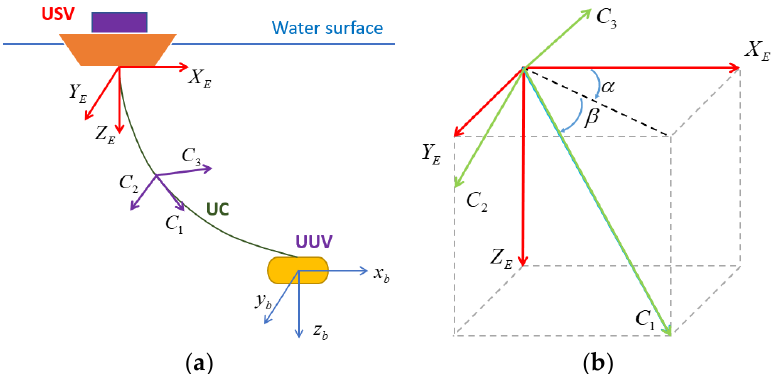
Figure 8. The coordinates of the system: ( a ) coordinates of complete system; ( b ) coordinate of the umbilical cable (UC).